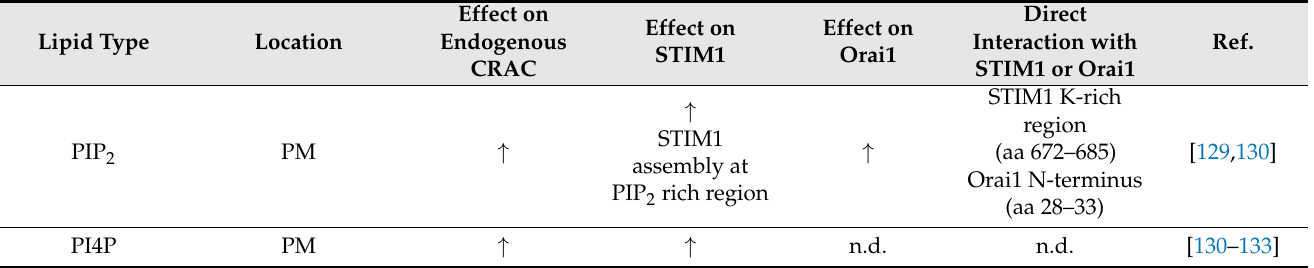
Table 1. List of lipids and ER-PM junctional proteins that modulate the function of STIM1 and/or Orai1. The lipids and ER-PM junctional proteins are listed together with their location in the cell critical for the modulatory effect on STIM1 and/or Orai1, their effects on the functions of the CRAC channel, STIM1, and Orai1, whether they interact directly with STIM1 or Orai1 and the corresponding